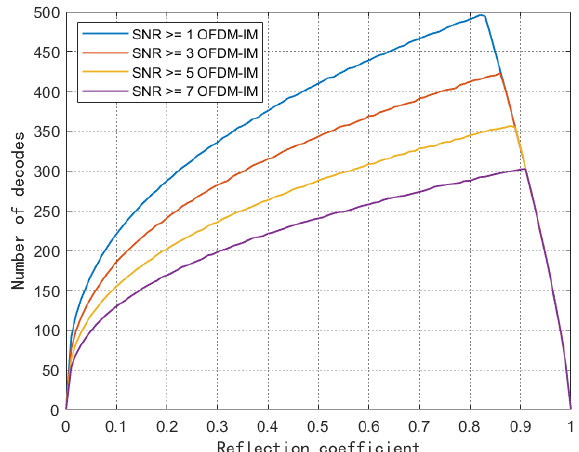
Figure 7. Re fl ection coe ffi cient and number of device decodes.